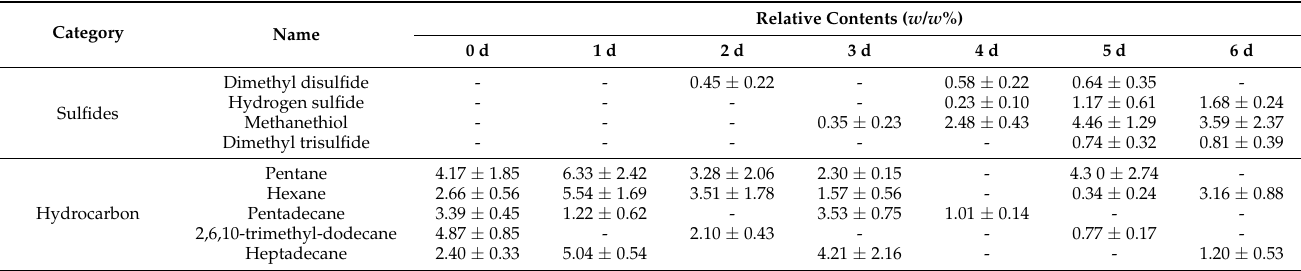
Table 2. The volatile compounds of beef during storage at 4 ◦